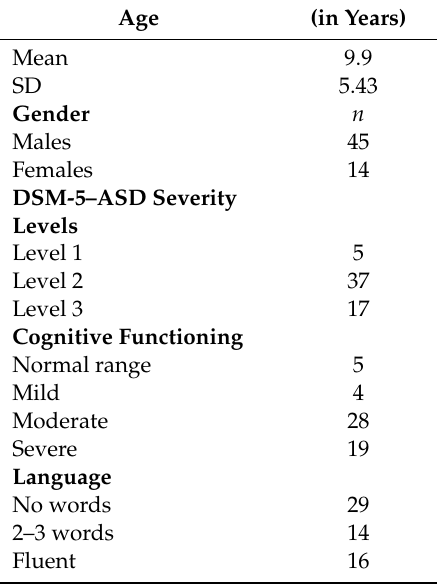
Table 1. Socio-demographic characteristics and functional profile of the